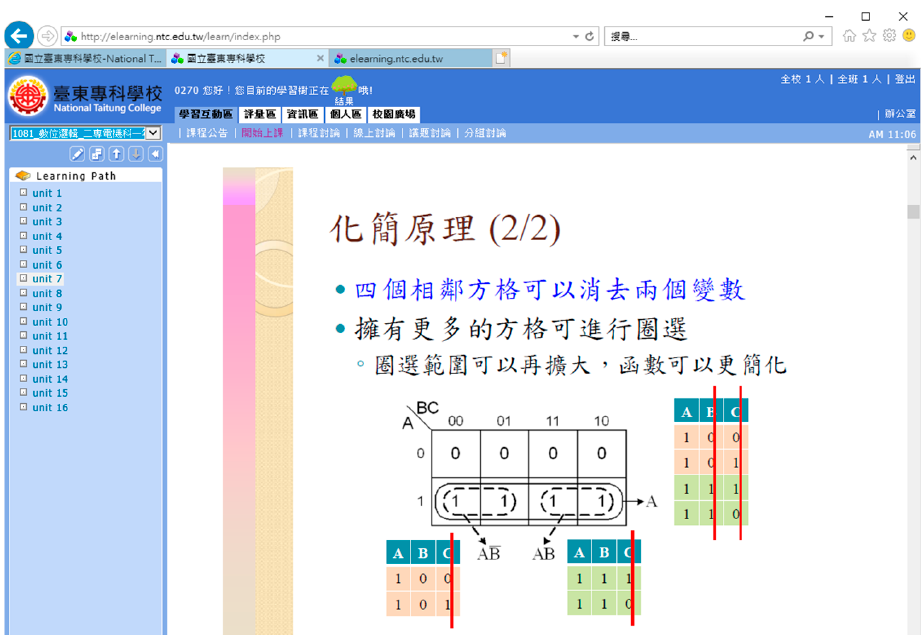
Figure 2. The homepage of the digital logic lecture videos stored in the E-media cloud of a junior Figure 5. Lecture Video Demonstration—Snapshot of Digital System Conversion Video. college in southeastern Taiwan. Figure 3. Lecture Video Demonstration—Snapshot of Digital System Conversion Video.